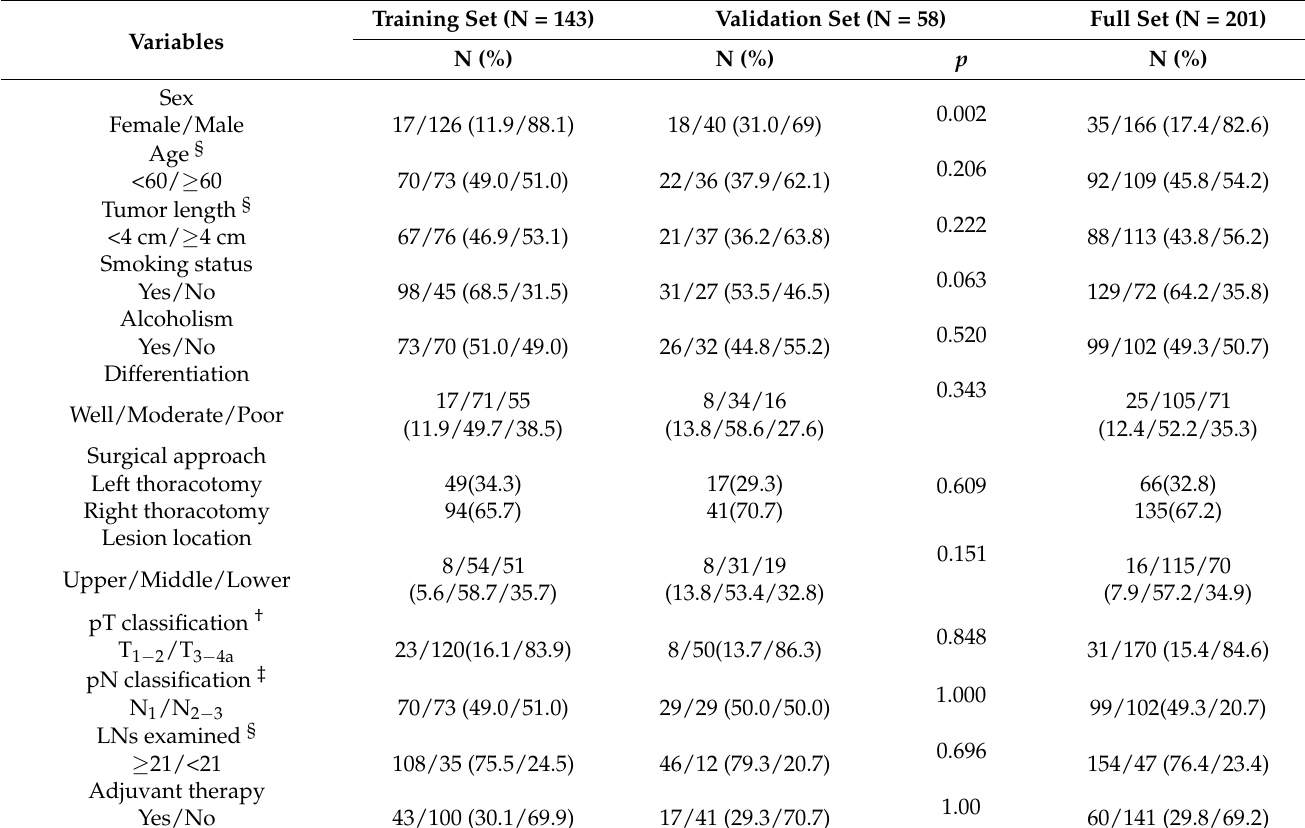
Table 1. Main clinical characteristics of patients in the training and validation